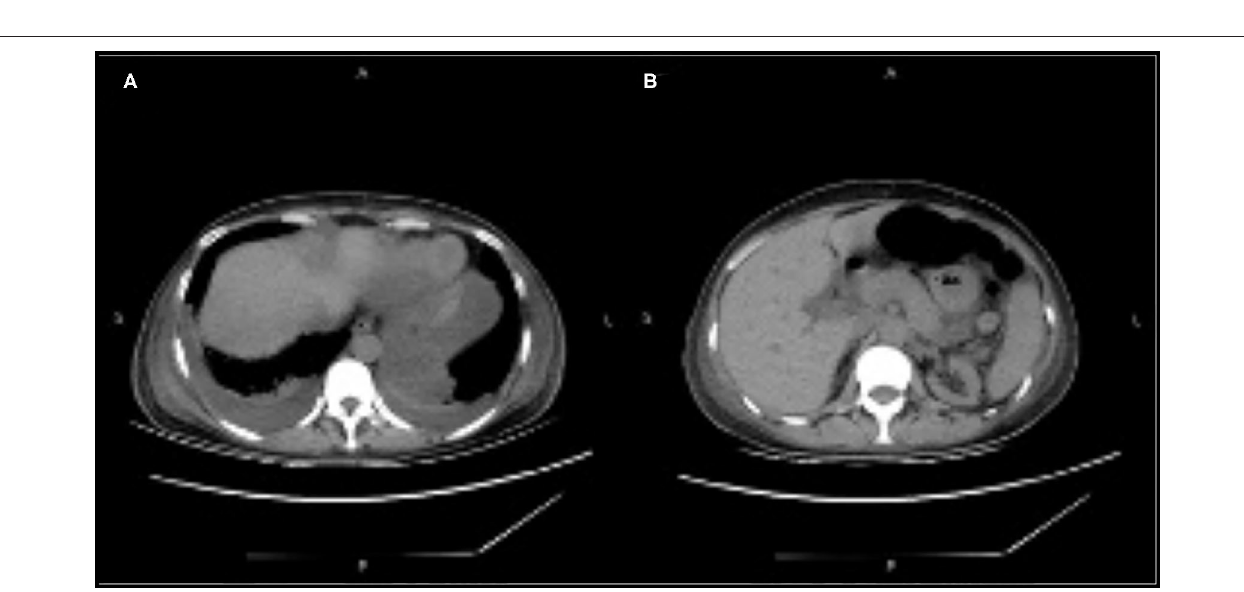
FIGURE 2 | (A,B) Computed tomography showing decreased bilateral pleural effusion and peripancreatic